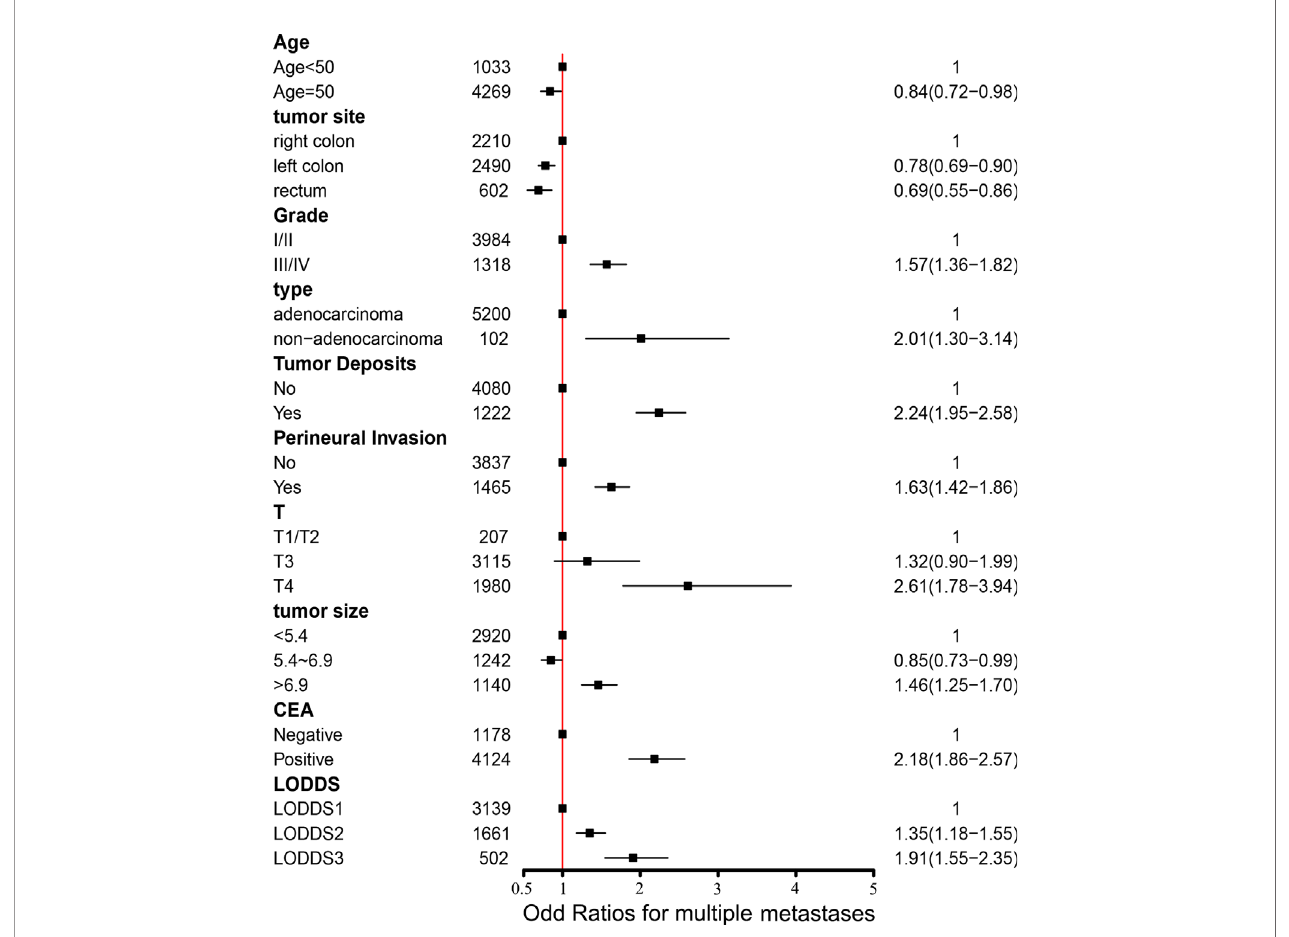
FIGURE 3 | Forest plot with odds ratios for multiple metastases. CEA, carcinoembryonic antigen; LODDS, the log of positive lymph nodes; I/II, well/moderately differentiated; III/IV,